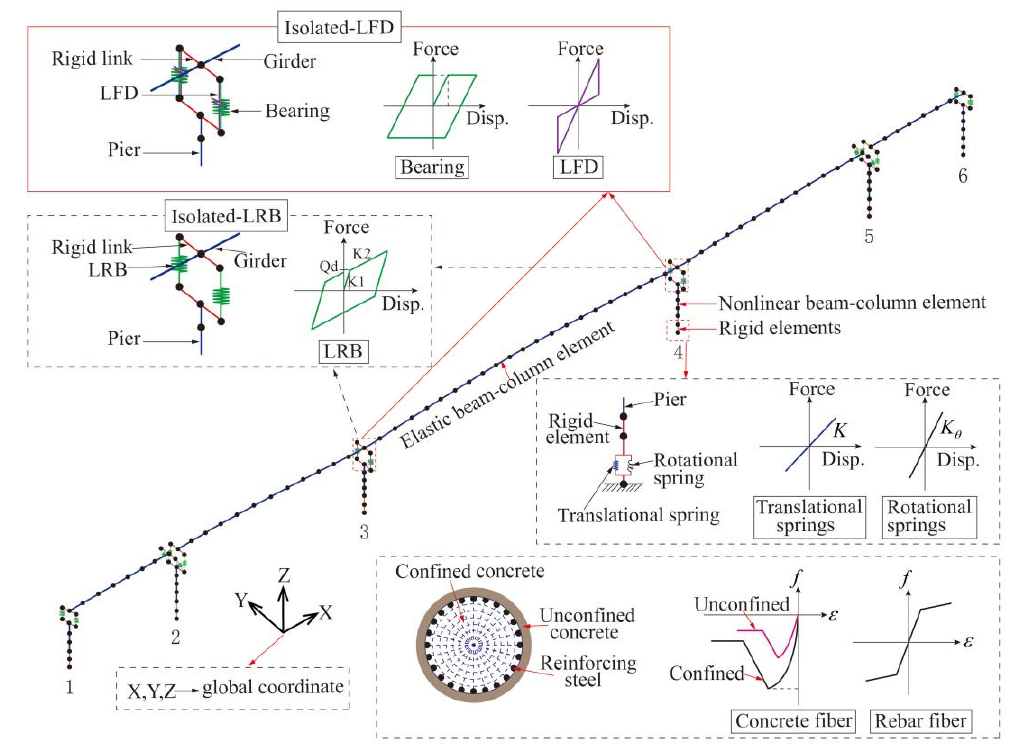
Figure 7. Numerical model of the prototype bridge.